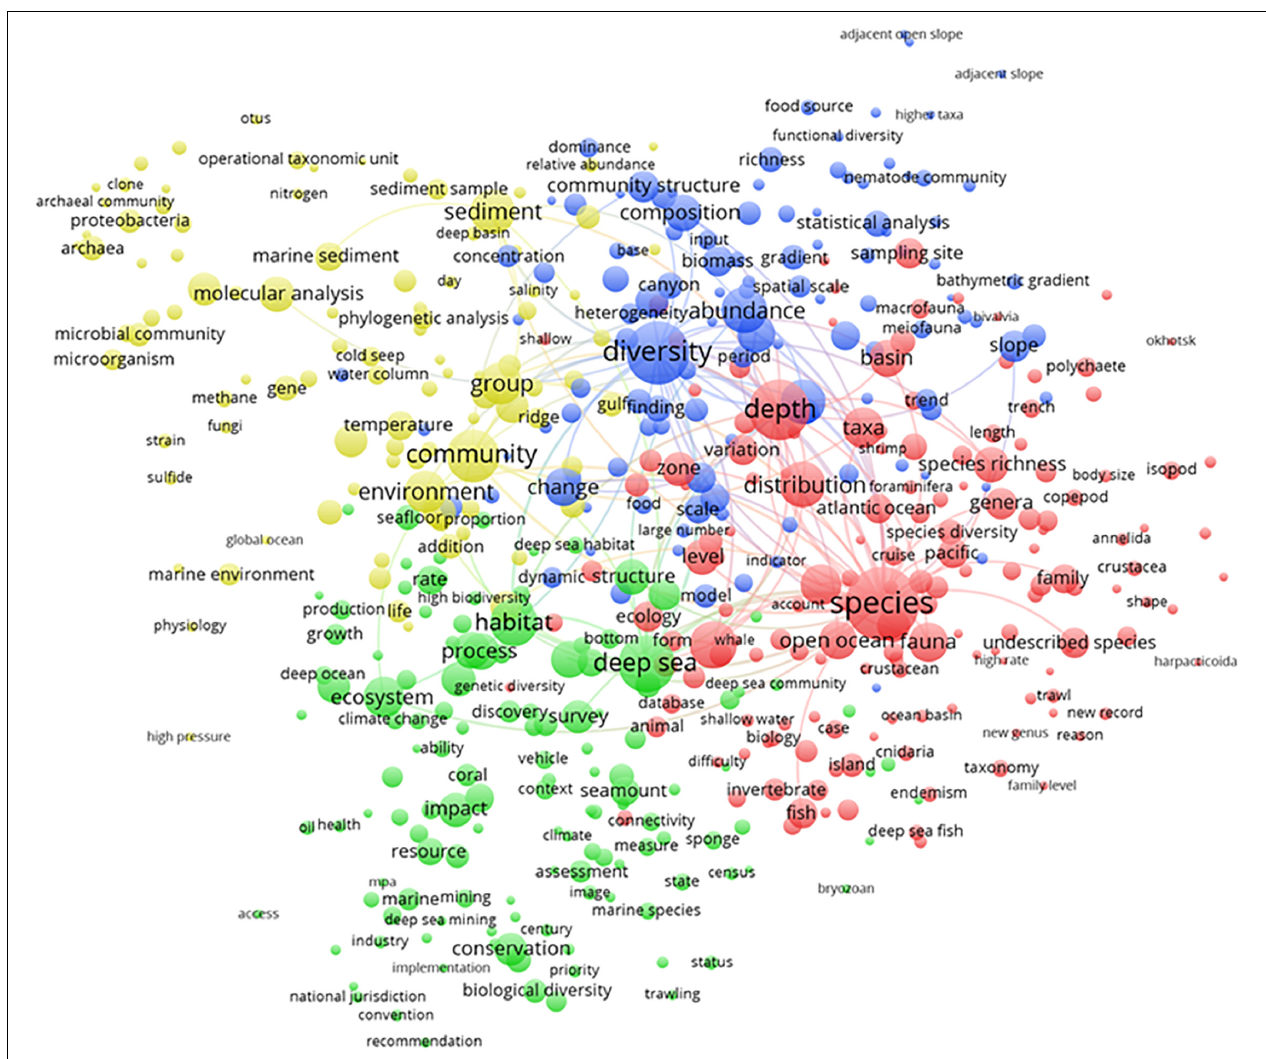
FIGURE 3 | Term map analysis output from 1993 to 2019 depicting the four major clusters, as major established and emerging topics for deep-sea biodiversity publications. Colors are used to identify clusters of related terms and are chosen arbitrarily. Different colors represent the terms belonging to different clusters (see detailed explanation in the text). Lines indicate at least 100 co-occurrence links between